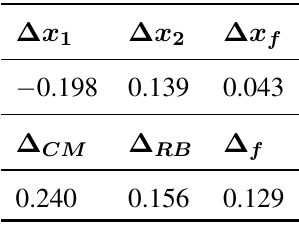
Table 3. Simulation results of the data fused by KF and MOIFA (units: